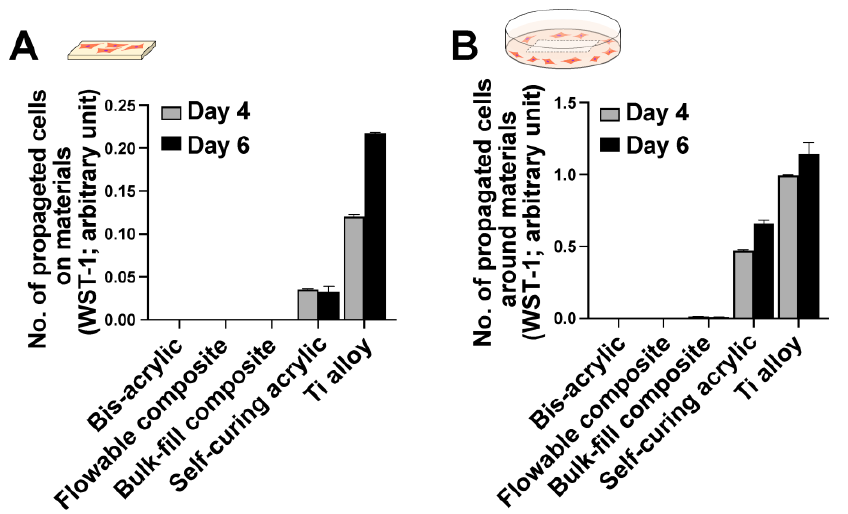
Figure 2. Propagation of fibroblasts on and around various dental restorative materials. Contact ( A ) and proximity ( B ) experiments were performed. The WST-1 assay was performed on culture days four and six to quantify the number of cells propagated on each material ( A ) and in the culture well around each material ( B ).